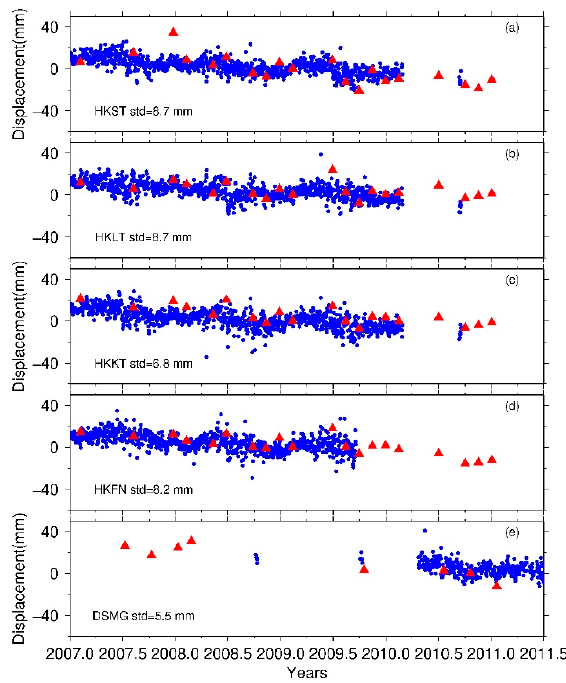
Figure 5. Deformation time series comparison between InSAR and GPS results. Blue dots represent the GPS time series, and red triangles represent the InSAR time series.